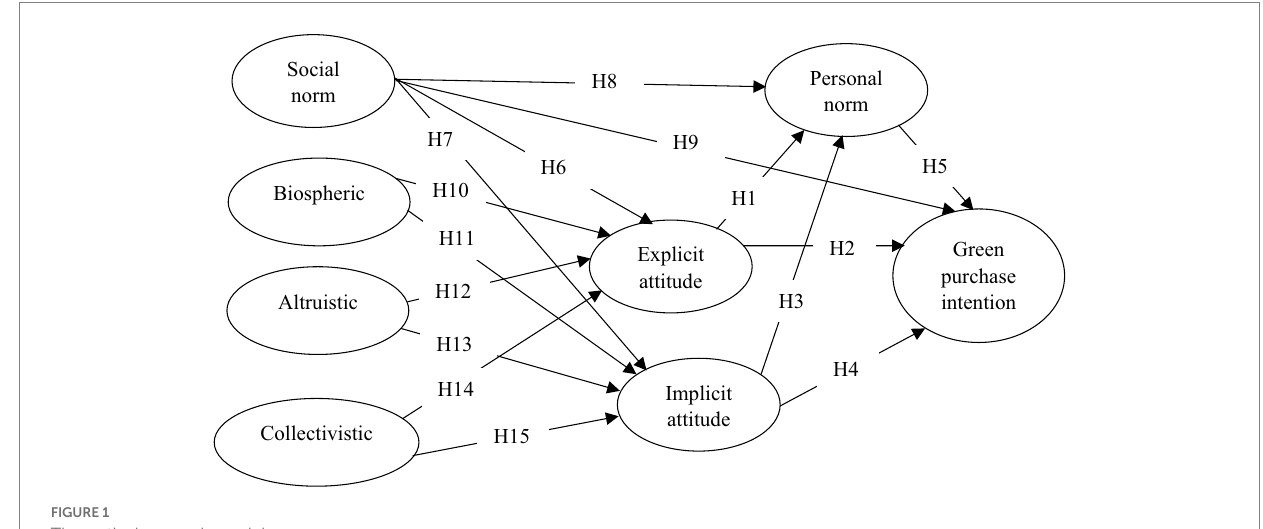
FIGURE 1 Theoretical research